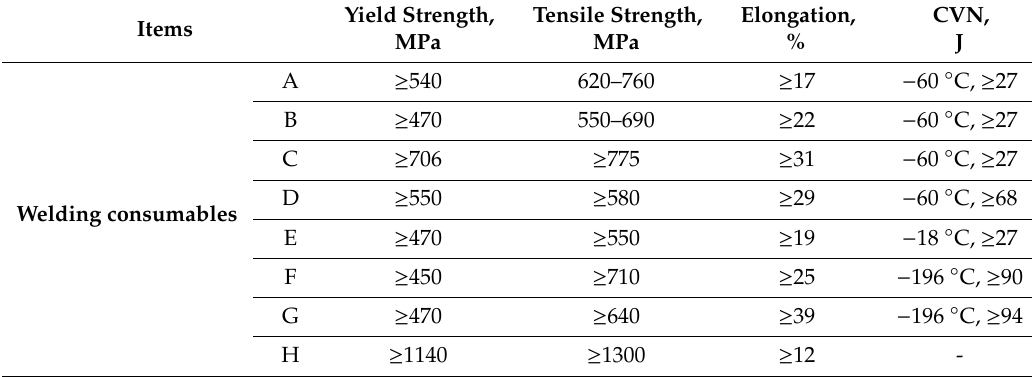
Table 5. Mechanical properties of each welding consumable.